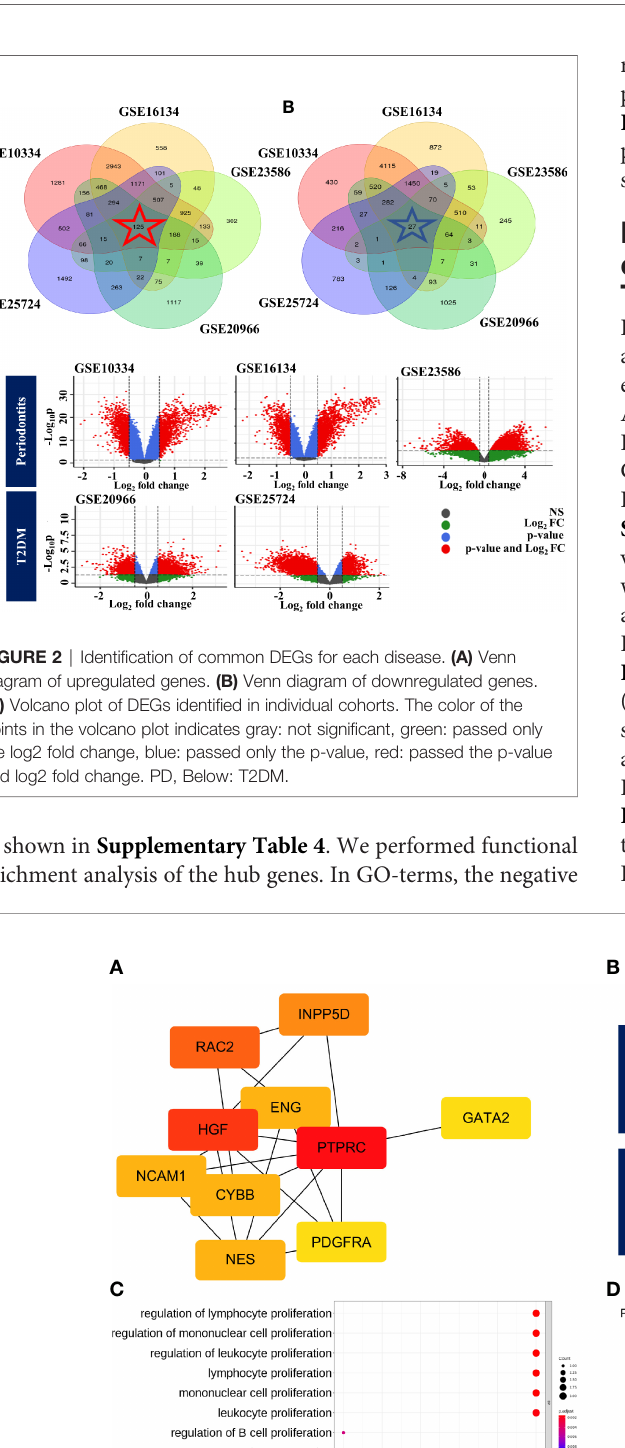
FIGURE 3 | PPI network construction, module selection, and identi fi cation of hub genes. (A) The top 10 highly connected genes based on degree score. (B) Boxplots of expression values in the individual cohorts of hub genes. Blue: Control group, Red: Disease group. (C) The signi fi cantly enriched BP terms of GO analysis with hub genes. The meaning of the dot color is as follows: red: adjusted p-value < 0.002, purple: < 0.004, blue < 0.008. (D) KEGG pathway analysis using hub genes. The meaning of the dot color is as follows: red: adjusted p-value < 0.002, purple: < 0.004, blue < 0.006.